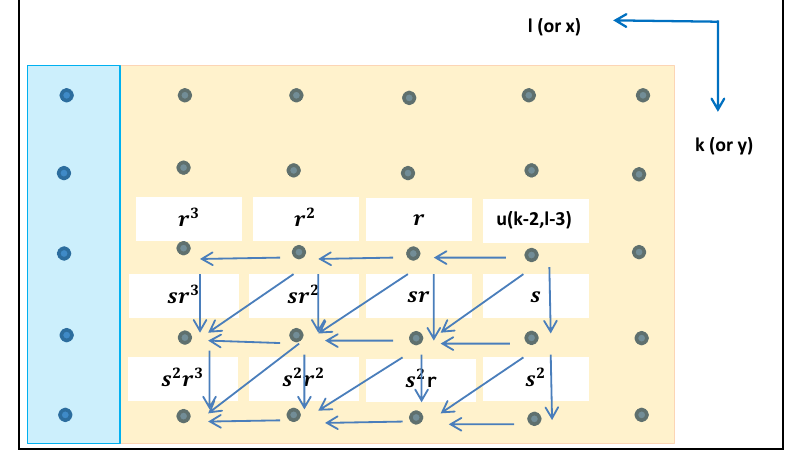
Figure A1. The “route” of to , the lower left grid location in the orange